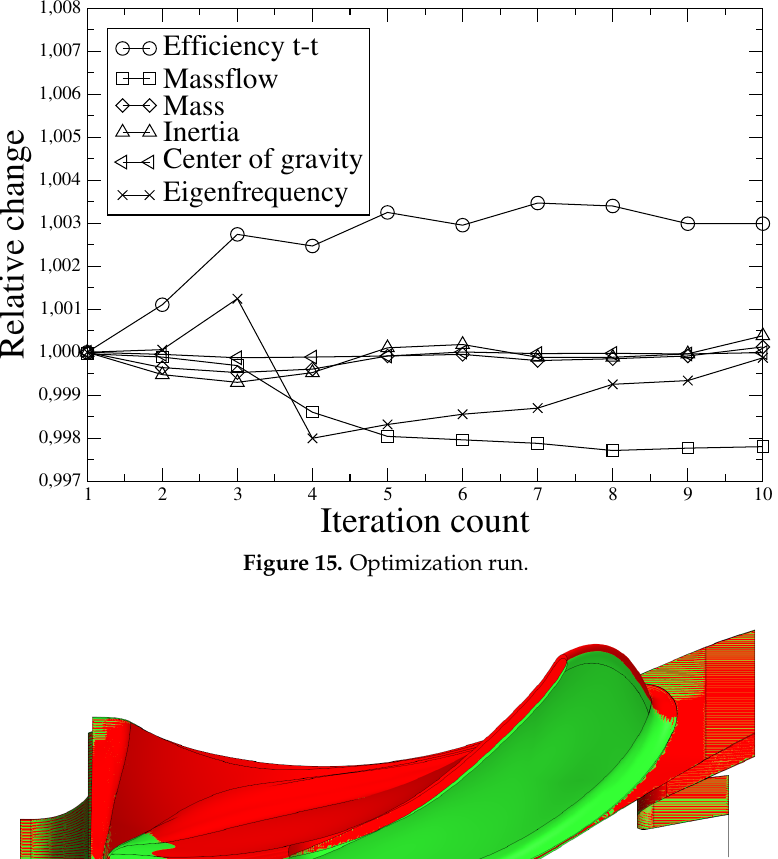
Figure 16. gradient-free design (iteration 1, red) and gradient-based design (iteration 8,